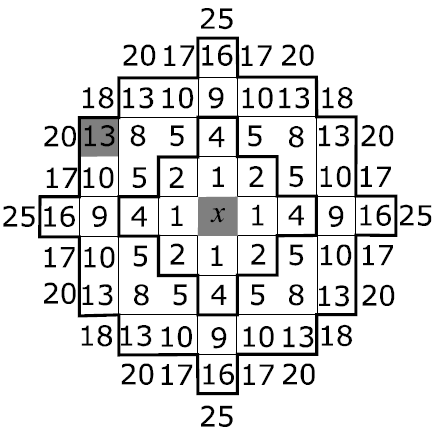
Figure 2. The distance squared between the central pixel x and its neighbors. Lines mark local windows Ω with different radii.